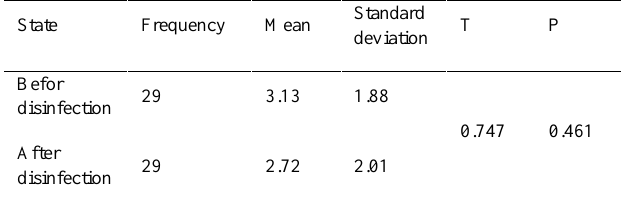
Table 2. colony count before and after disinfection in A hospital (T-Test)